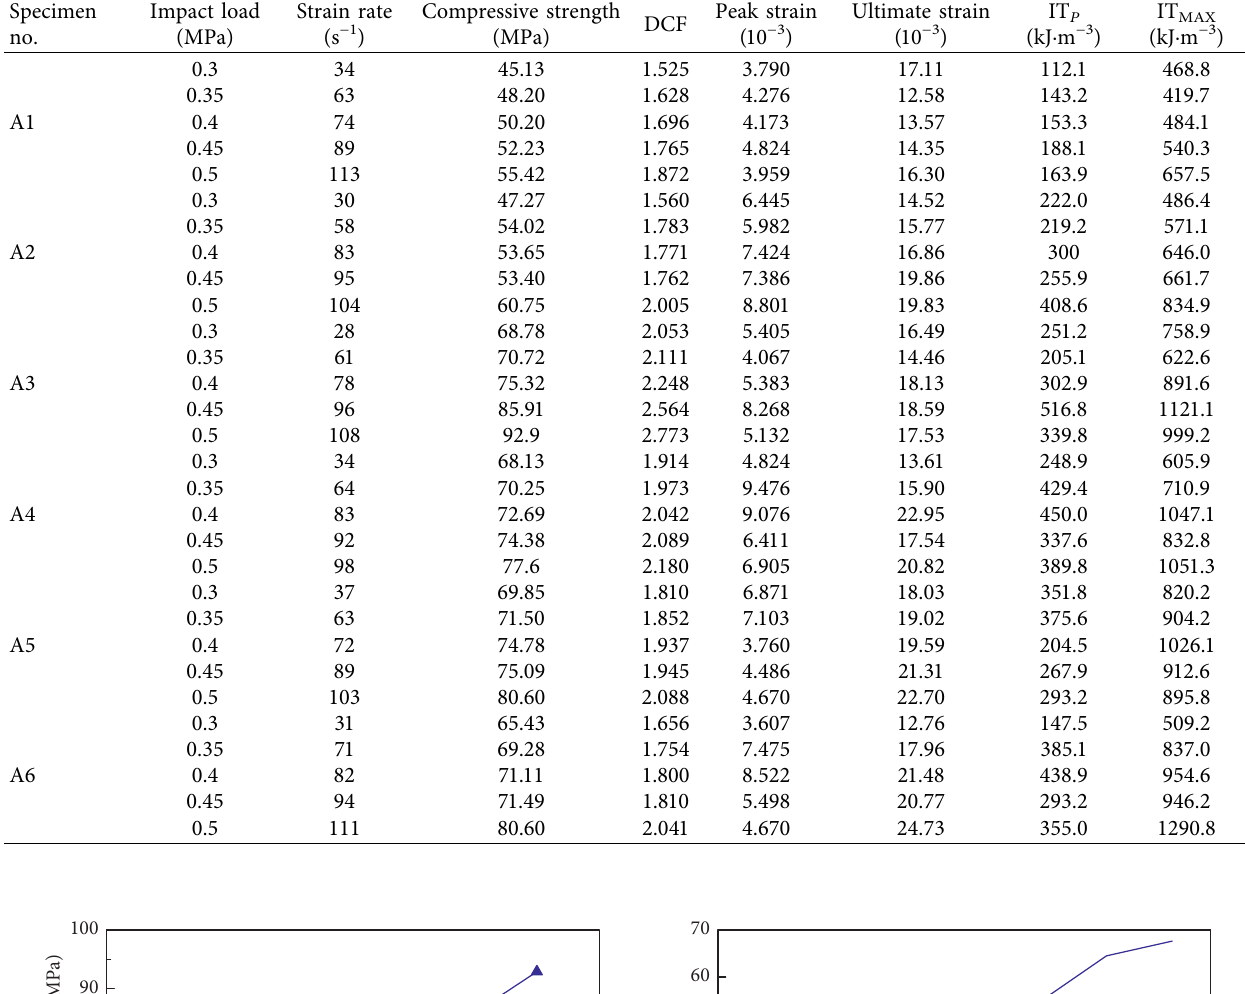
Table 4: The dynamic characteristic parameters of HPFRC in the SHPB